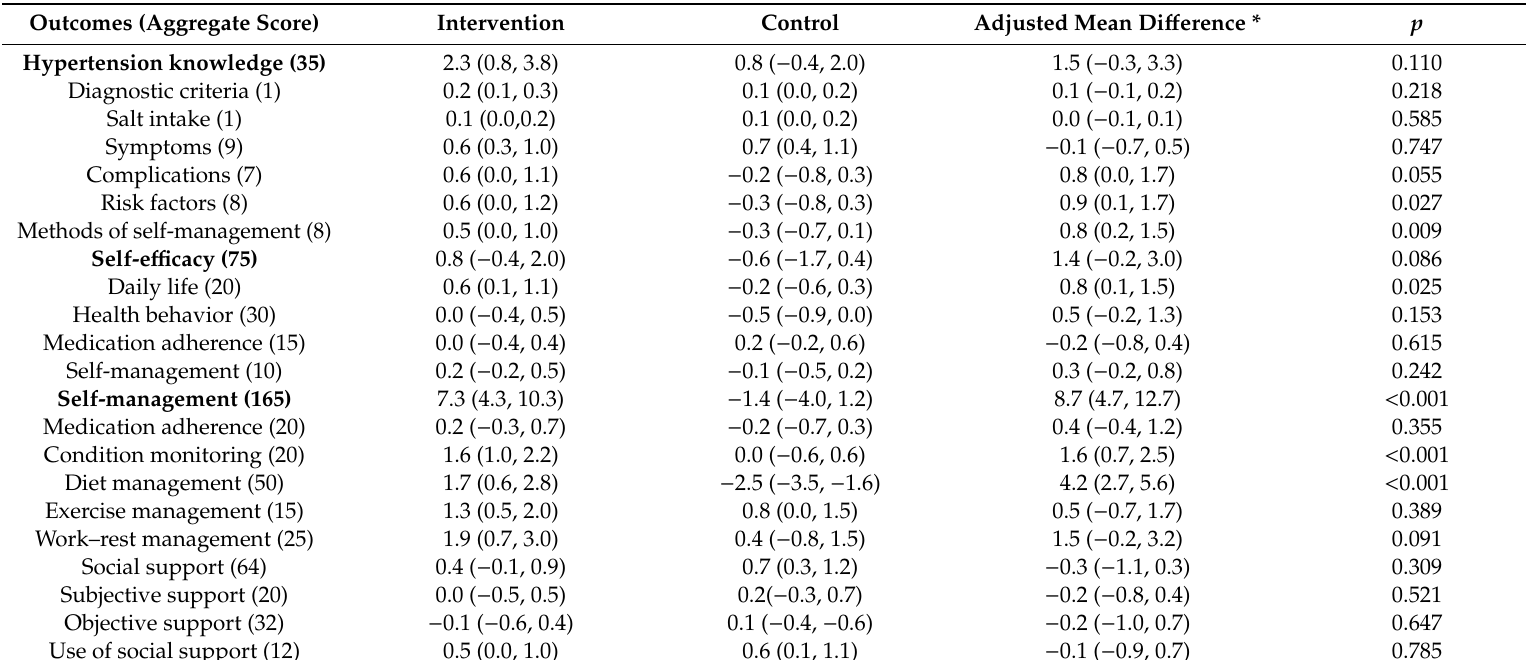
Table 4. Mean changes (95%CI) in hypertension knowledge, self-e ffi cacy, self-management, and social